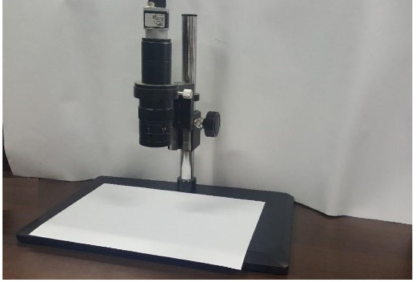
Figure 3. The experimental environment of this